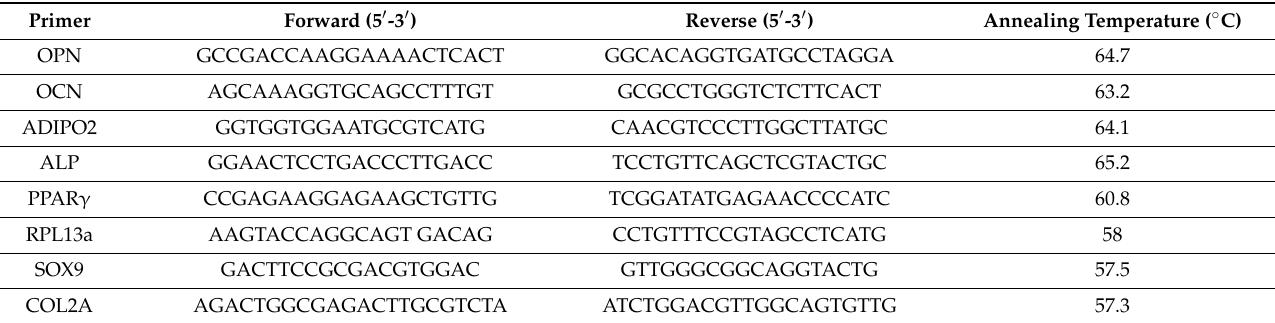
Table 3. Primers used for semi- and quantitative RT-PCR